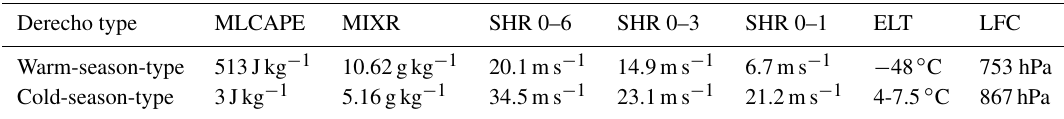
Table 3. Median values of sounding parameters derived from derechos of the warm-season (top) and cold-season (bottom) type. From left to right: mixed-layer CAPE (MLCAPE), mixing ratio (MIXR), 0–6km shear (SHR 0–6), 0–3km shear (SHR 0–3), 0–1km shear (SHR 0–1), equilibrium level temperature (ELT), and level of free convection